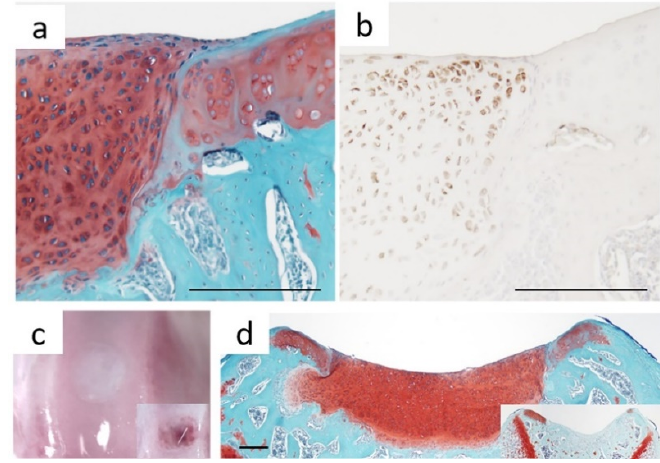
Figure 4. Cell sheets adhere, remain localized, and induce cartilage regeneration in vivo without any additional support materials. Histological and immunohistochemical staining of rat knee cross-sections 4-weeks post cartilage sheet transplantation show close interfacing with the native cartilage and ( a ) areas of positive hyaline-like regeneration (Safranin-O), correlating to ( b ) reten- tion and viability of human cells (hVimentin—brown color) in trochlear groove chondral defects. Regenerated tissue filling the defect at 4 weeks post-transplantation ( c ) macroscopically and ( d ) histologically (Safranin-O) (right corner boxes shows defect only controls) resembles native carti- lage. Scale bars = 200 μm. Adapted and reprinted from Kondo M., Kameishi S., Grainger D. W. & Okano T. Novel therapies using cell sheets engineered from allogeneic mesenchymal stem/stromal cells. Emerg. Top. Life Sci. 4 (6): 677–689 (2020) with permission from Portland Press.